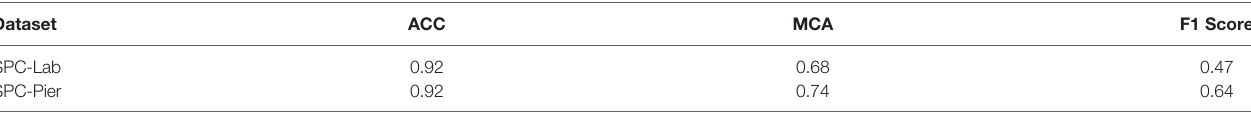
TABLE 2 | Average classi fi cation results of a double fi ned-tuned model tested on independent held out samples collected by the SPC-Pier and SPC-Lab.